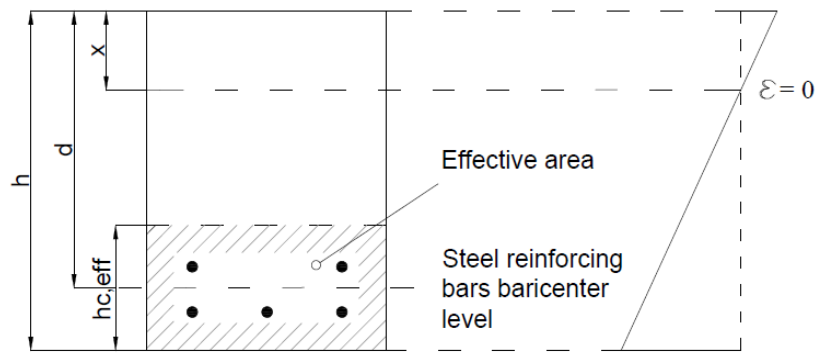
Figure 2. Effective area for rectangular section defined by Eurocode 2 [1].